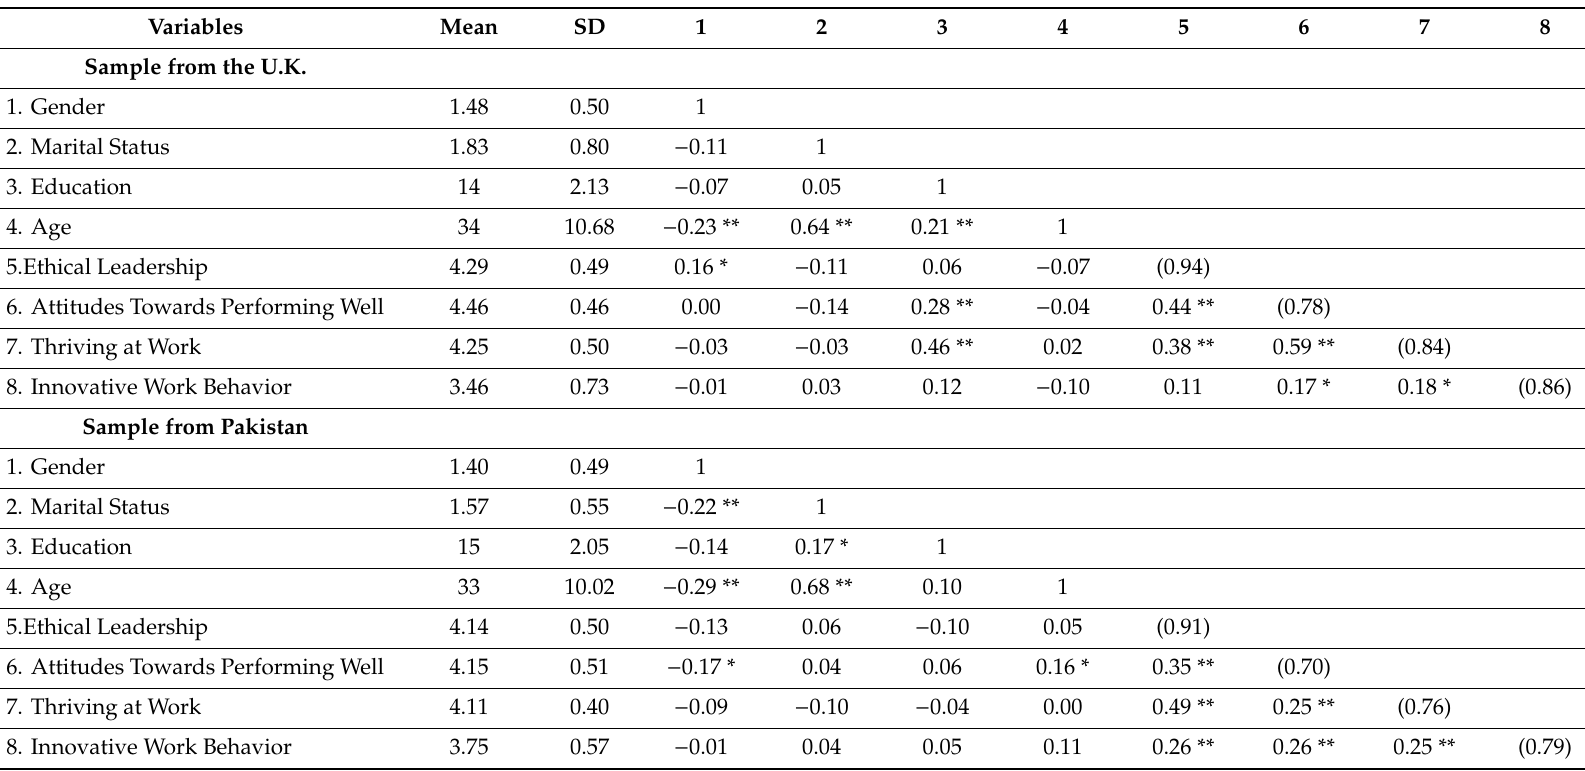
Table 3. Descriptive Statistics and Correlation